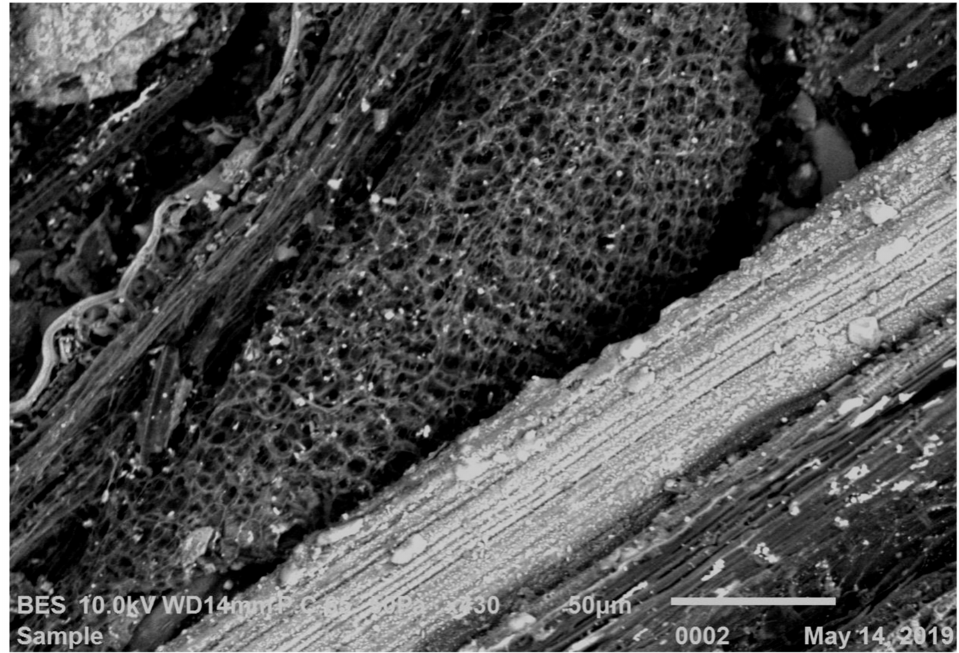
Figure 2. Rice straw biochar surface at 1000 × magnification under SEM. Table 4. Selected physico-chemical properties of rice straw, rice husk, rice straw biochar, and rice husk biochar.